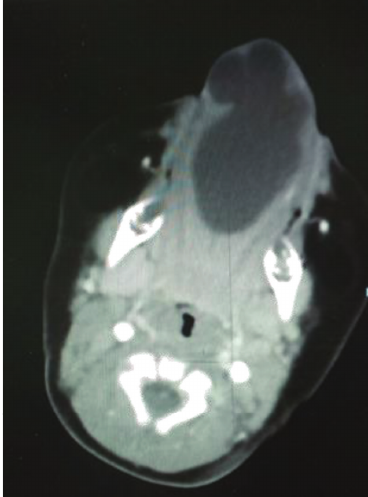
Figure 3: CT neck showing a 4 × 3 × 2 cm cyst in the floor of the mouth.